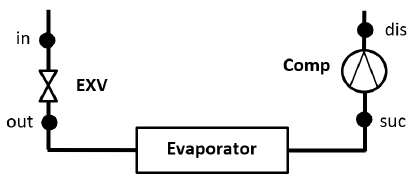
Figure 1. Compressor and Electronic expansion valve (EXV) scheme in vapor compression refrigeration system.